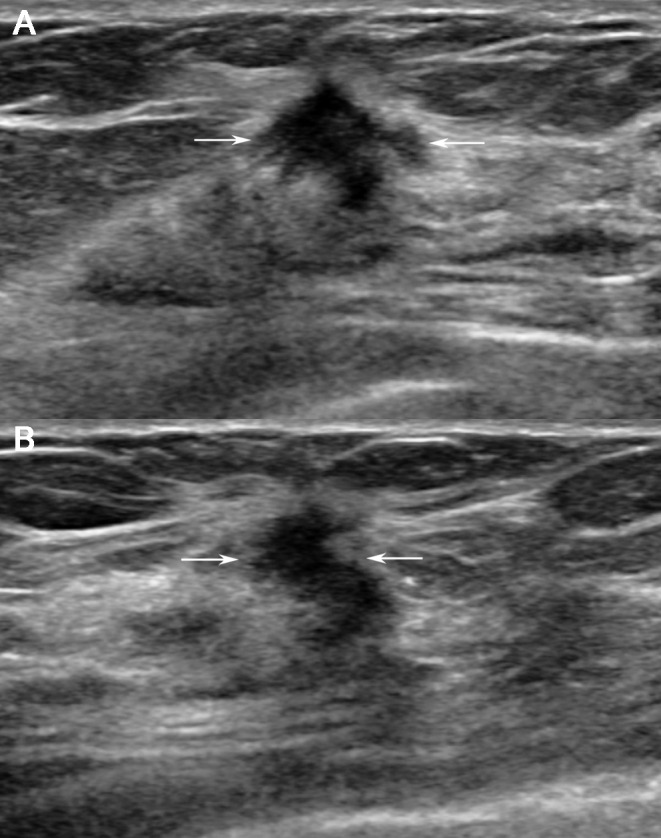
A 63-year-old woman with a recurrence score of 13 (i.e., low risk).US images (A and B) showing an irregularly shaped, hypoechoic mass (arrows) with spiculated margins that is not parallel to the skin (tumour roundness score = 28.45). Surgery confirmed invasive ductal carcinoma with LN metastasis. Immunohistochemistry tests demonstrated PR positivity, HER2 negativity, and negative Ki-67 results.